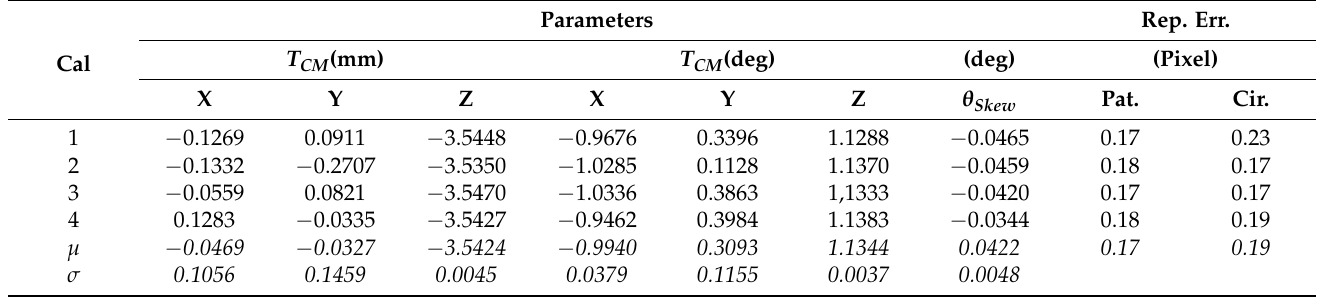
Table 8. Calibration results for 4 different experiments on a two-axis mechanism (right eye). Parameters Rep.